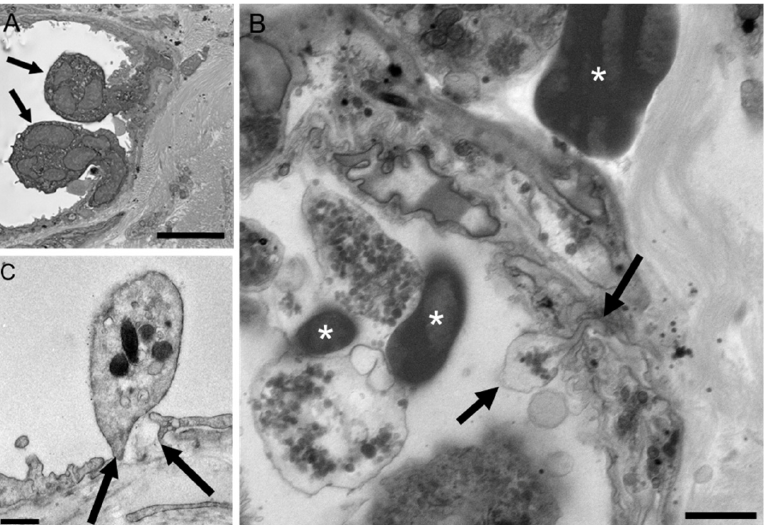
Figure 7. Representative electron micrographs of PMN and platelet extravasation in WT mice 8 h after corneal abrasion. ( A ) Two PMNs (arrows) engaged in diapedesis across the venular endothelium. ( B ) Extravasating platelet (bounded by two arrows) in the process of crossing the endothelium. Intravascular and extravascular RBCs (*) are also evident. ( C ) Intravascular platelet positioned over a discontinuity (arrows) in the endothelium. Small gold particles (5 nm) decorate the platelet surface and denote platelet-specific CD42b immunolabeling. Bar = 5 µm ( A ); Bar = 2 µm ( B ); Bar = 0.5 µm ( C ).